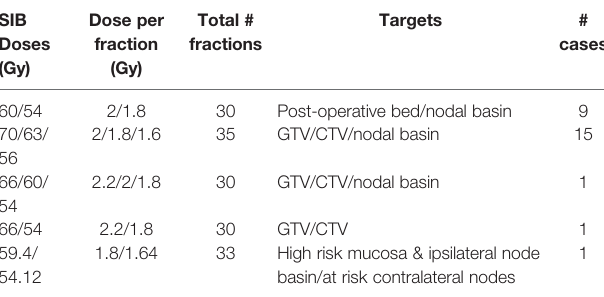
TABLE 2 | Treatment plans prescriptions from patient